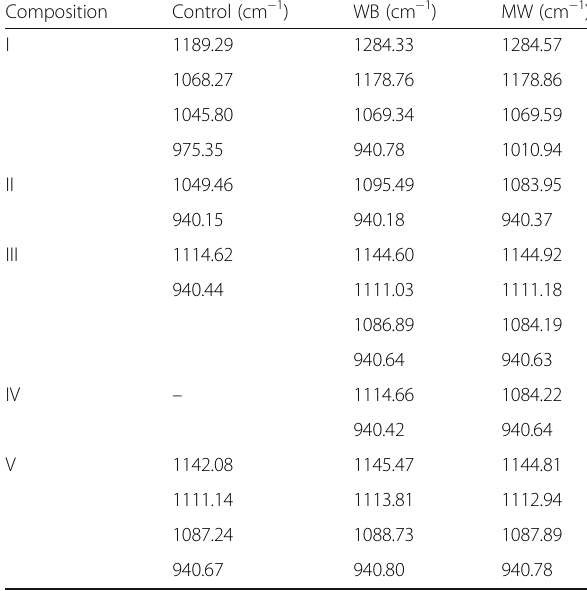
Table 4 FT-IR absorption peaks of SO 42 − in chromium complex from each component in 33% basicity chromium sulphate tanning